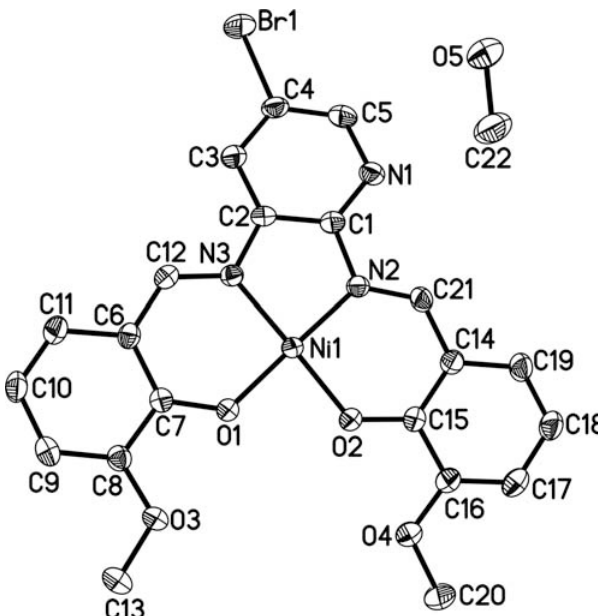
Table 2. Atomic coordinates and displacement parameters (in Å 2 )